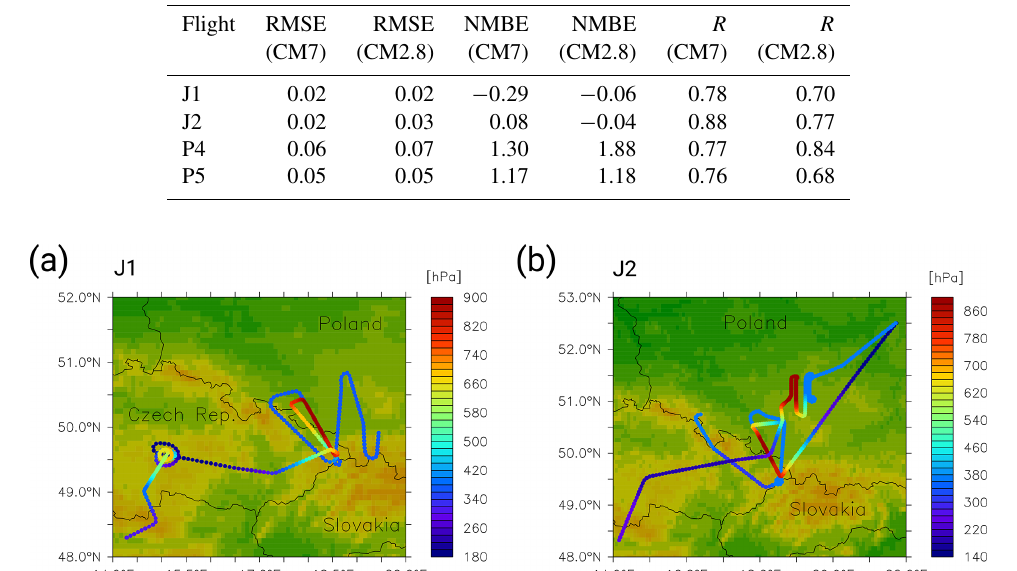
Table 3. Summary of the results of the statistical analysis of J1, J2, P4 and P5 compared to the simulated CH4_FX mixing ratios (bias- corrected). Listed are the root mean square error (RMSE) in micromoles per mole (µmolmol − 1 ), the normalized mean bias error (NMBE) in percent and the correlation coefficient ( R ) for the model domains CM7 and CM2.8.